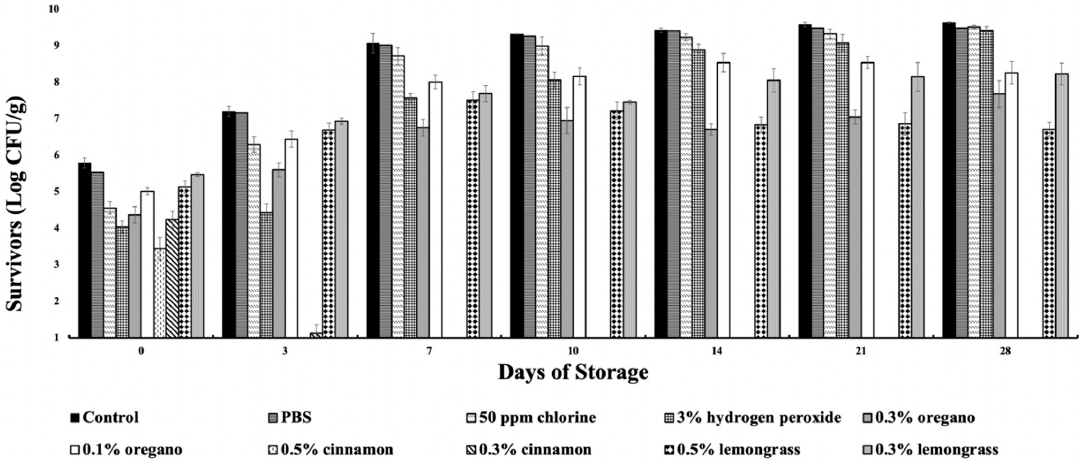
Figure 3. Survival of P. fluorescens on Iceberg lettuce treated with 0.3 and 0.1% oregano; 0.5 and 0.3% cinnamon; and 0.5 and 0.3% lemongrass oil microemulsions for 2 min and stored at 4 °C. All values are an average of three replicates. Error bars represent the standard deviation from the mean value.